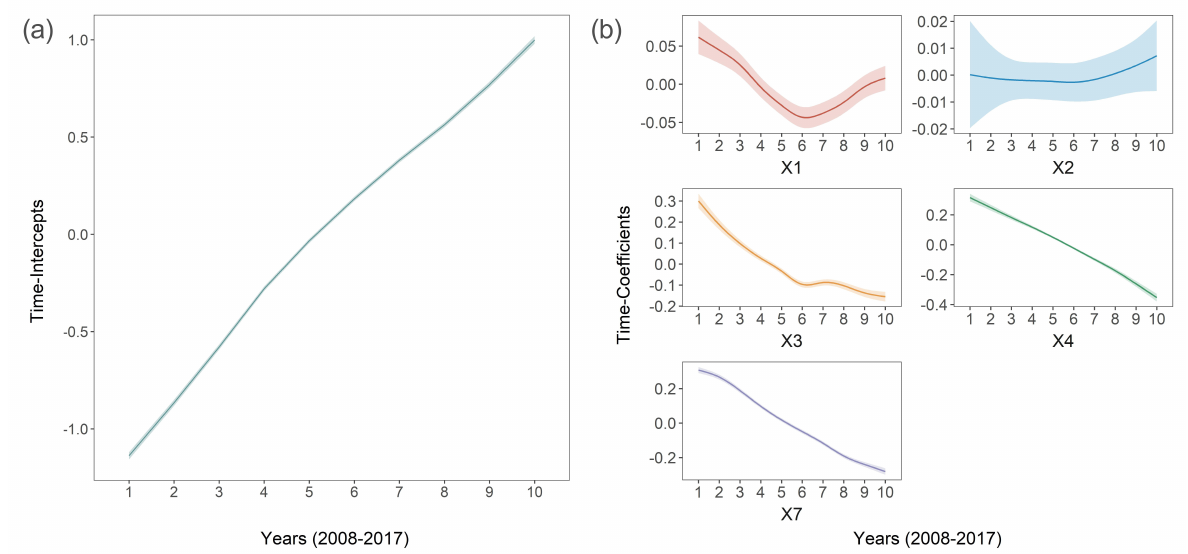
Figure 4. ( a ) Time-intercepts (TIs) graph: the temporal trend of China’s tourism industry from 2008 to 2017, and ( b ) time-coefficients (TCs) graphs (covariates’ temporal nonstationarity): the impacts of drivers (X1–X4 and X7) on tourism are varying over ten years. Covariates with time-scale variations: X1—average wage of employed persons in urban units, X2—employment density of urban units, X3—GDP per capita, X4—population density, and X7—NDVI. Shadow areas in each facet are the 95% Bayesian CIs to describe the uncertainties of time-scale